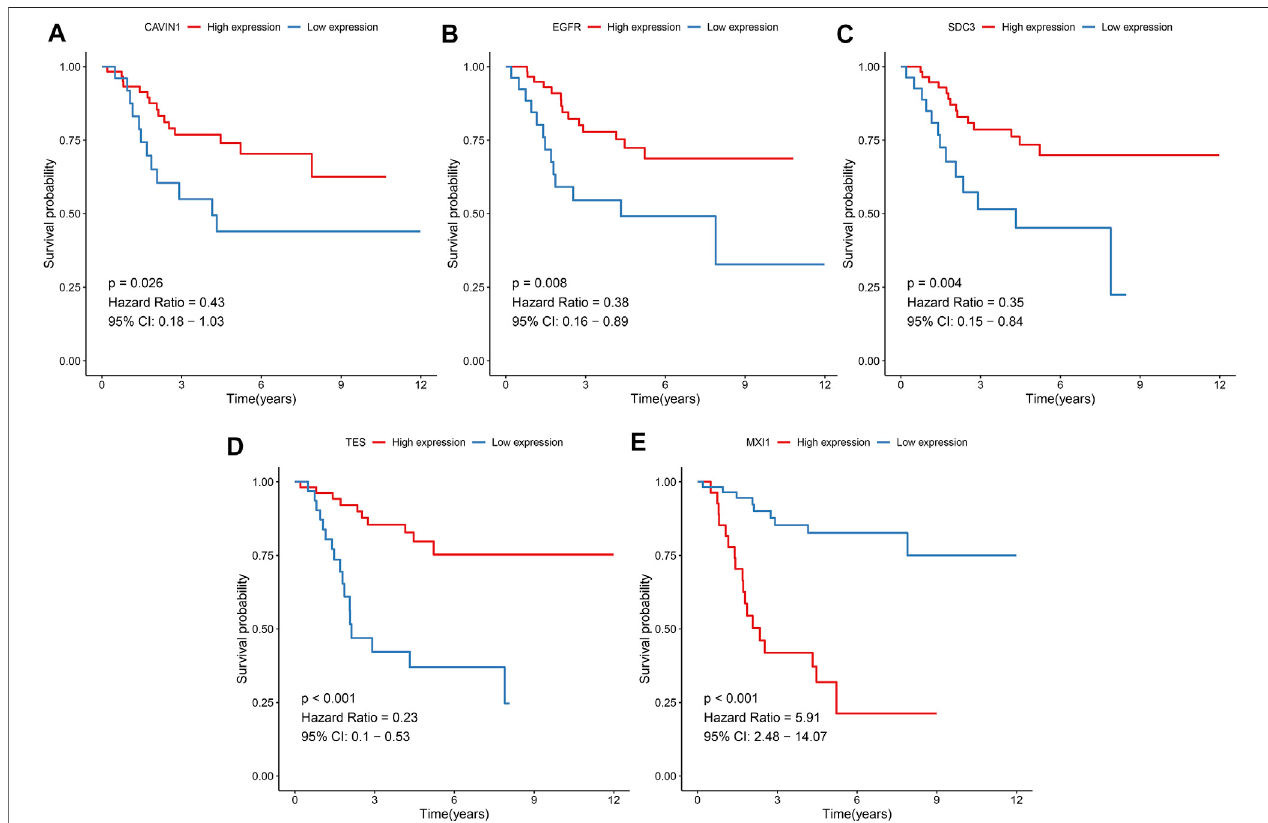
FIGURE 7| Prognostic values ofhypoxic genes from the gene signature in osteosarcoma.Kaplan-Meier curves for overall survival ofosteosarcoma patients in the high and low (A) CAVIN1, (B) EGFR, (C) SCD3, (D) TES, and (E) MXI1 expression groups from the TARGET cohort. The survival differences were assessed via log- rank